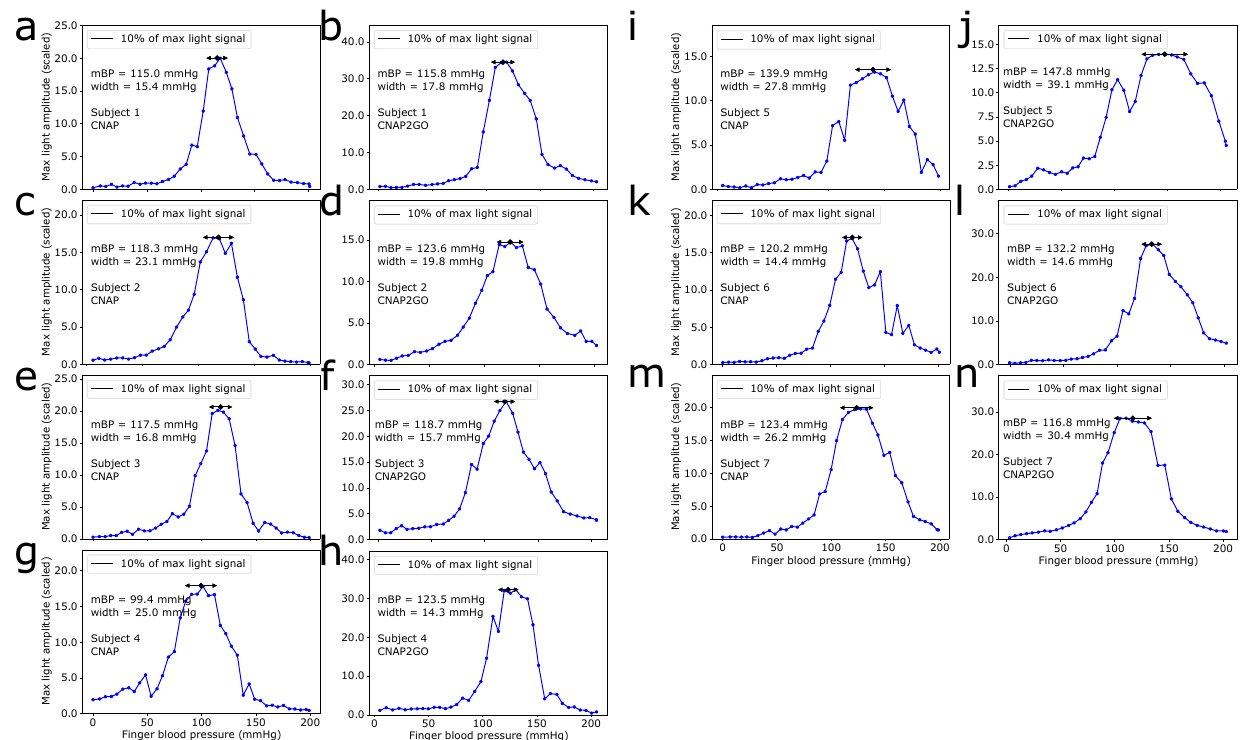
Fig. 9 Oscillometric curves from 7 subjects obtained from the CNAP2GO prototype. Compared are the results of the fl uid- fi lled bladders in panels a , c , e , g , i , k , and m to the results of the standard CNAP with pneumatic control in panels b , d , f , h , j , l , and n , respectively. Mean blood pressure (mBP) and width of the Gaussian curves are denoted in each fi gure. The width is also demonstrated by black arrows. Measurement points (dots) are connected by straight